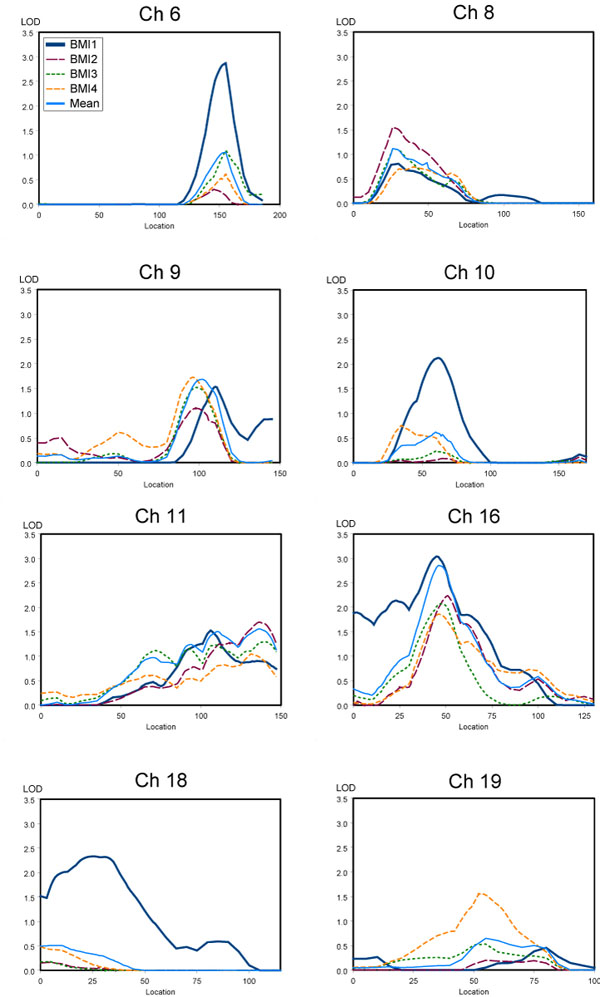
Selected chromosomes from genome scan results for BMI